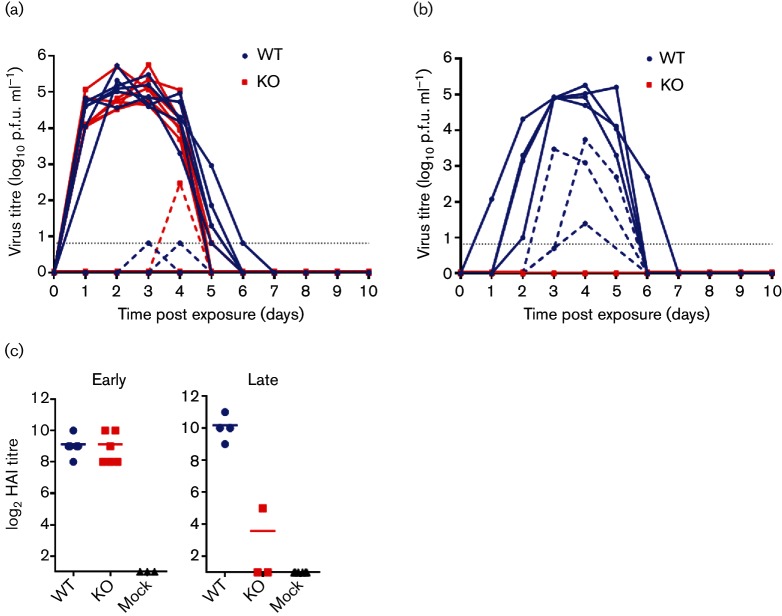
Transmission to naive contacts introduced at 1 and 5 days post inoculation. (a, b) Infectious virus titres in buccal (solid lines) and cloacal (dashed lines) swabs from naive contact chickens housed with either WT (blue) or KO (red) infected chickens. Contacts were exposed to infected chickens at either (a) early (1 day post inoculation) or (b) late (5 days post inoculation) time points. Grey baselines indicate the limit of detection. (c) HA inhibition titres on serum from contacts exposed to chickens inoculated with WT (blue circles) or KO (red squares) UDL01 at early (1 day post inoculation) or late (5 days post inoculation) time points. Serum was collected at 14 days post exposure and titred against the virus used for inoculation.